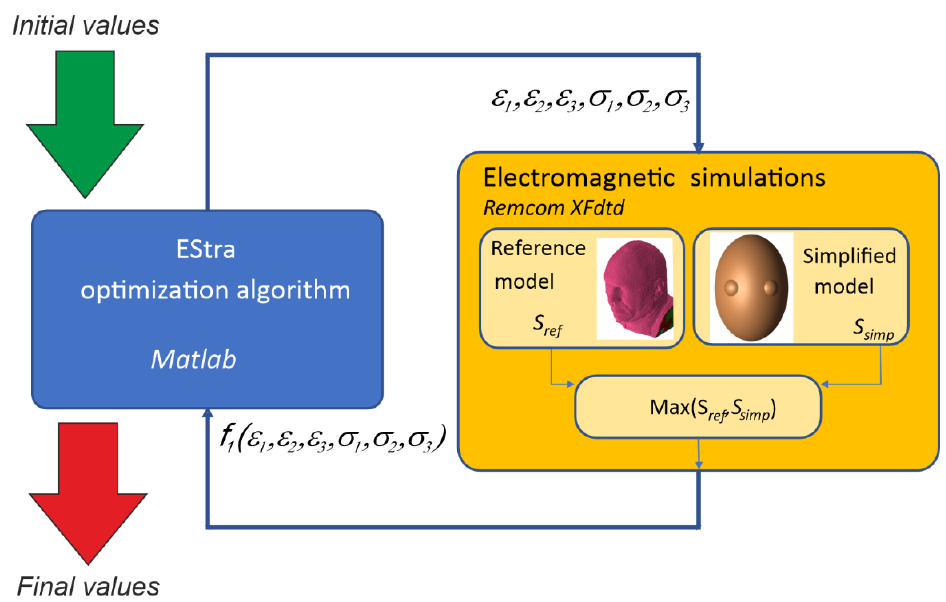
Figure 6. The procedure of the optimization of the head model. Table 3. The material properties of the simplified model of the face: initial values and final values.